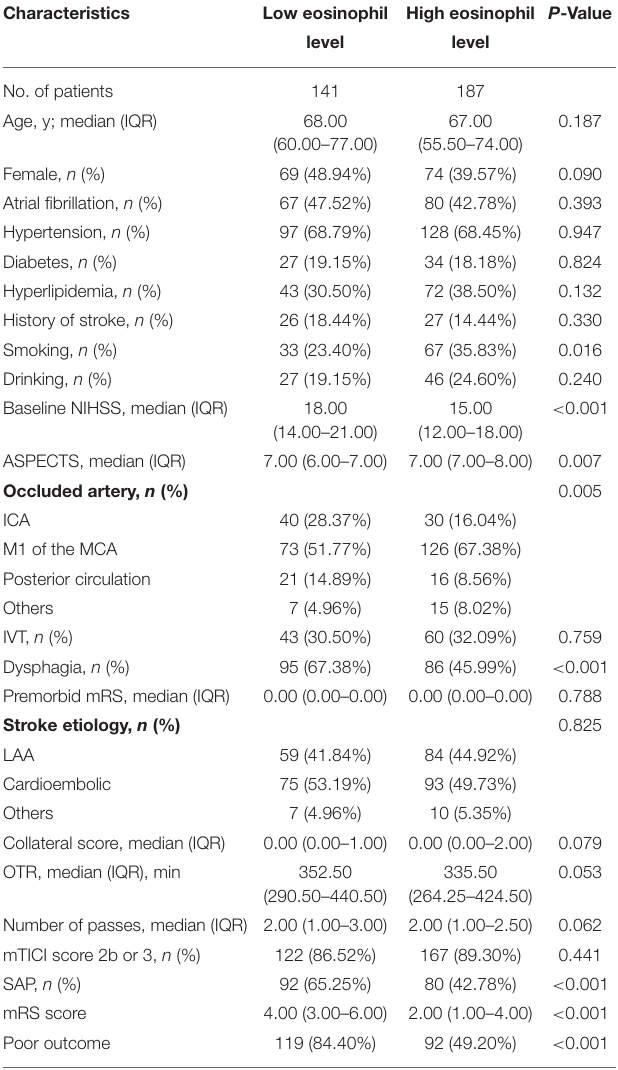
TABLE 1 | Baseline characteristics of study participants according to the eosinophil